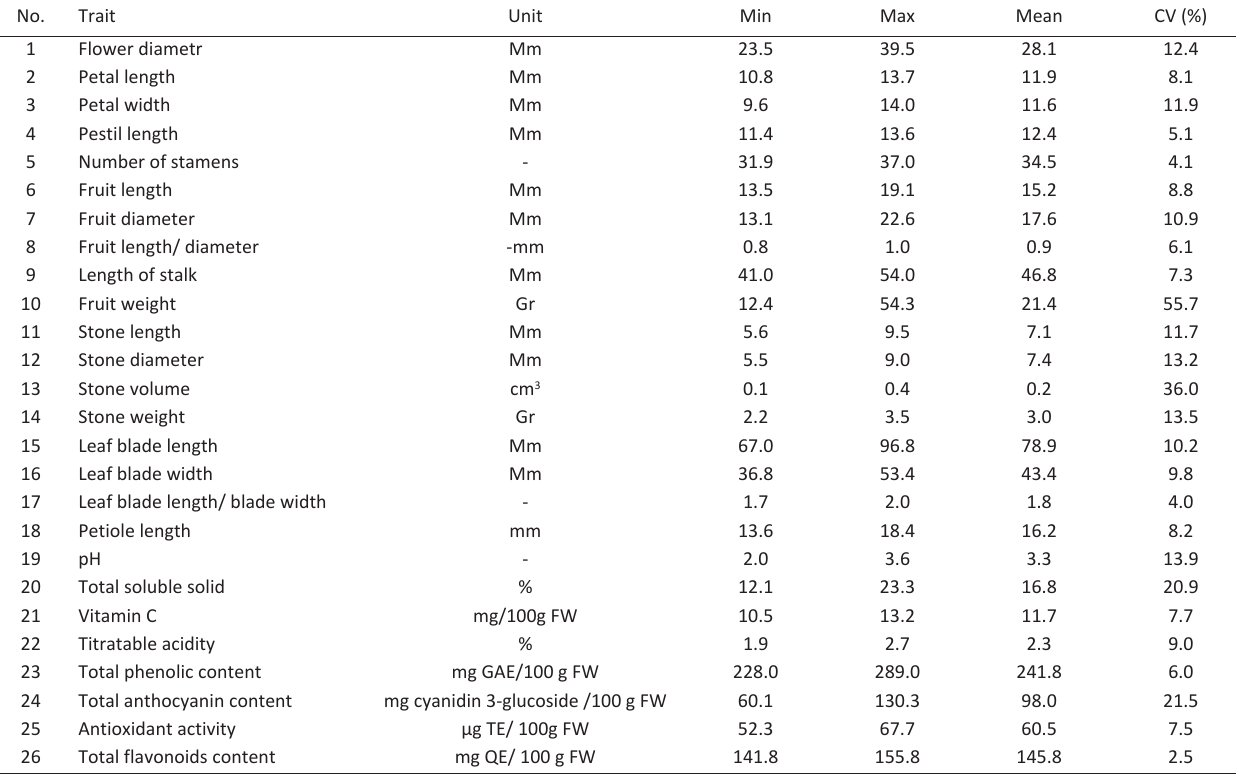
Table 1 - Sixteen qualitative traits and their states and codes studied of sour cherry genotypes